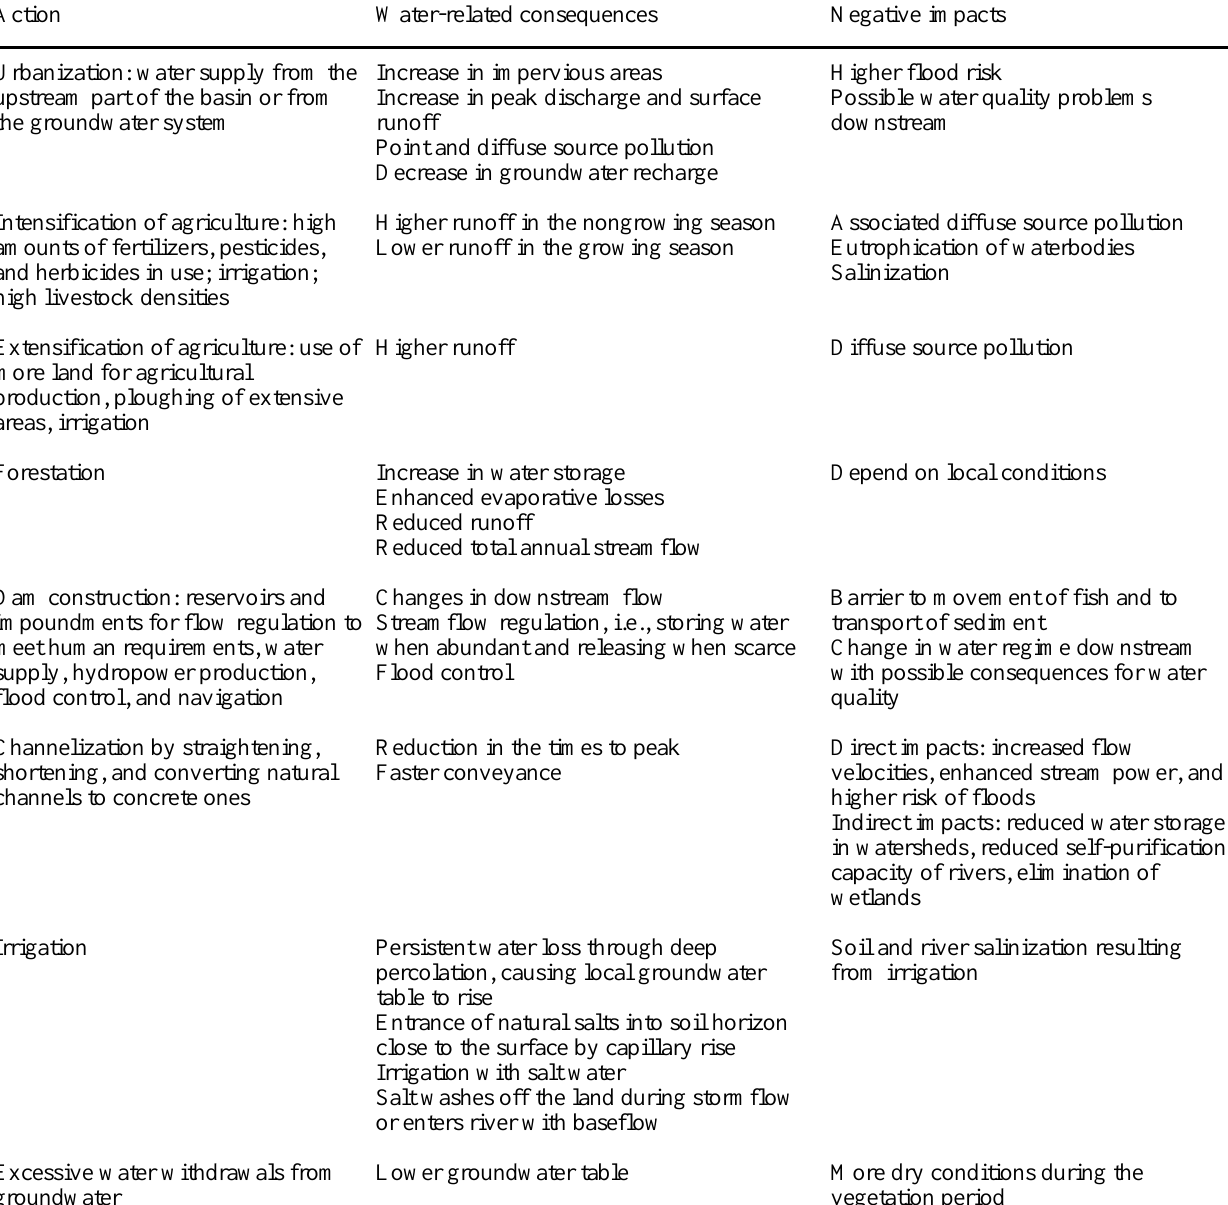
Table 2. Examples of human actions in river basins, their water-related consequences, and negative